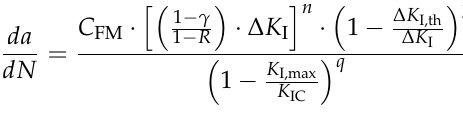
Figure 4. Simulation results of the clinched joints and initial crack: ( a ) The maximum principal stress distribution in the clinched joints; ( b ) The initial semi-circular crack at the location with the maxi- mum value for principal normal stress.